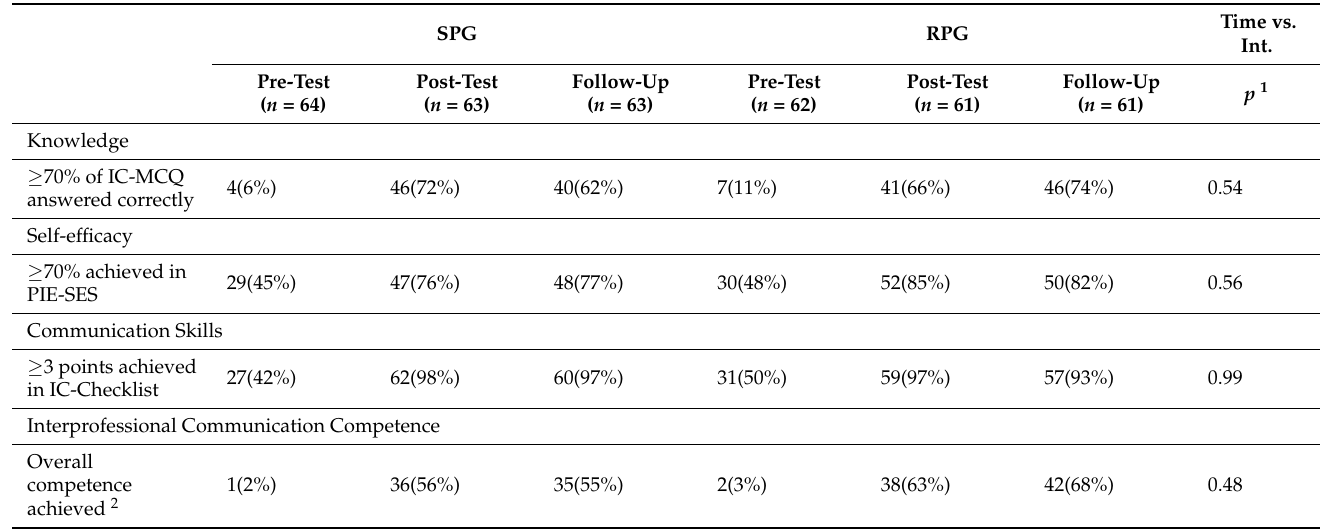
Table 2. Counts (proportions) of participants who achieved the benchmark for all variables measuring competence in interprofessional communication and GEE analysis.